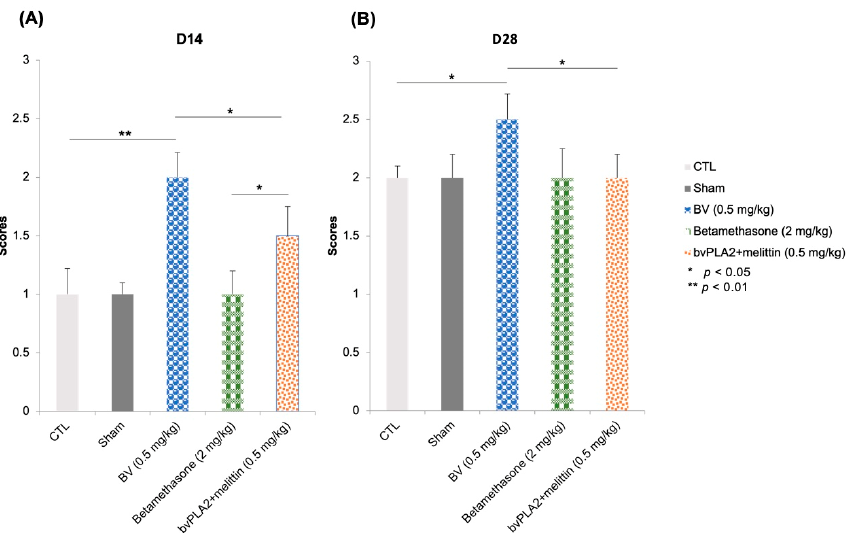
Figure 2. Chromatographic profile of Morocco bee venom: 1—apamin; 2—phospholipase A2 (PLA2); 3—melittin; IS—internal standard (cytochrome c, 25 µ g/mL).